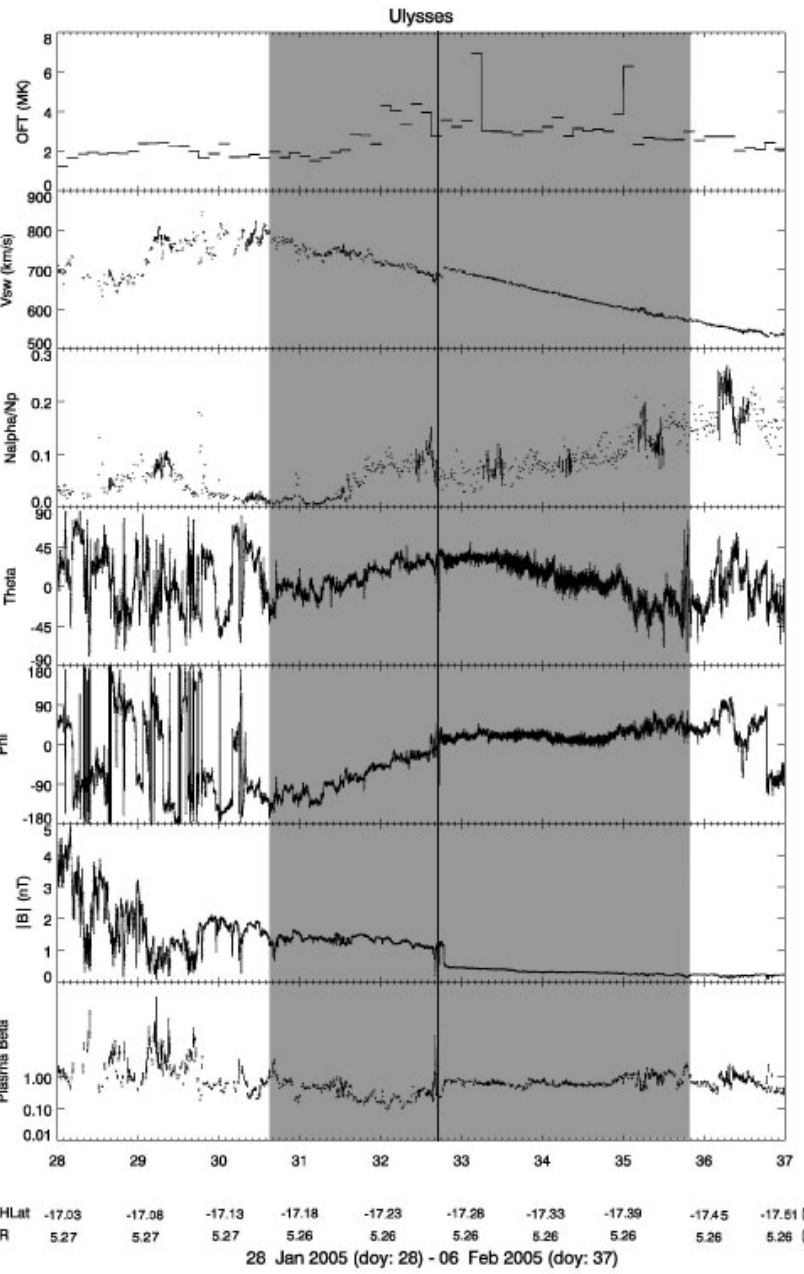
Fig. 14. Ulysses observations of a MC (shaded area) in January 2005. The vertical line marks the end of the smaller cloud considered as a second possibility in Sect.